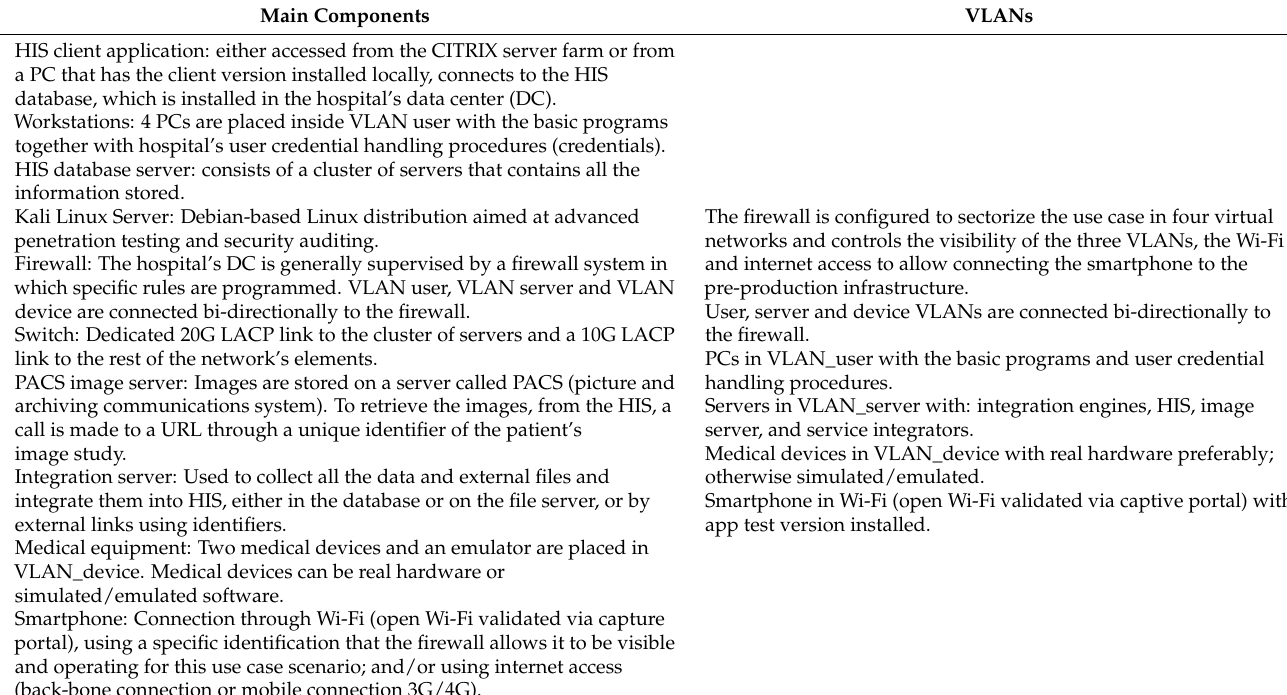
Table 1. Main components of the infrastructure and sectorization with VLANs. Main Components VLANs